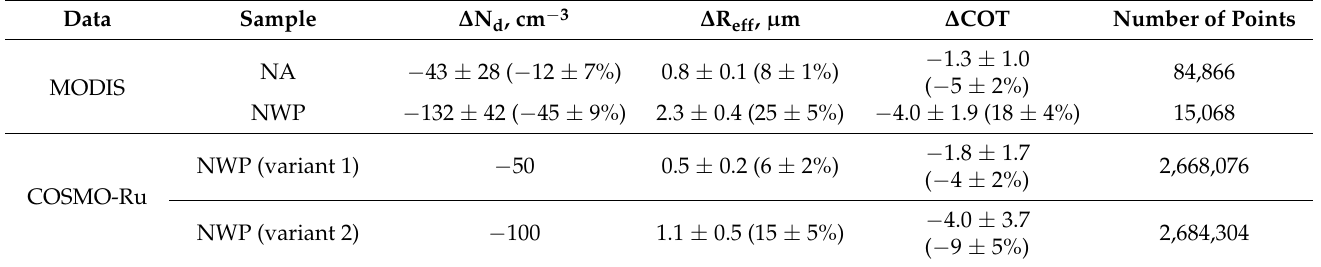
Table 3. Observed and simulated changes in cloud microphysical and optical characteristics in